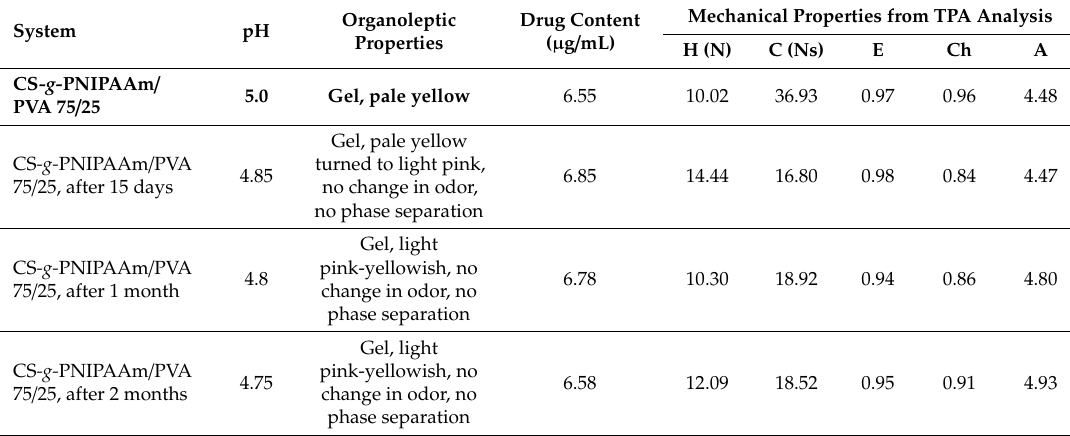
Table 4. Parameters determined after conditioning of the gel